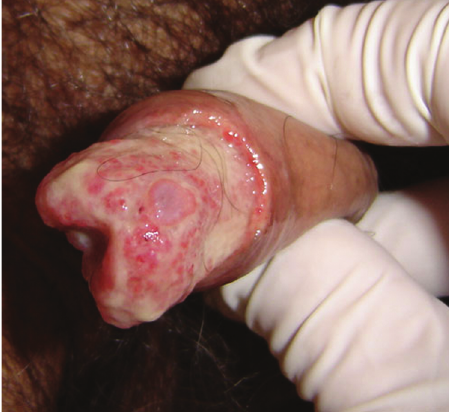
Figure 2 – A penile lesion after dorsal incision of the